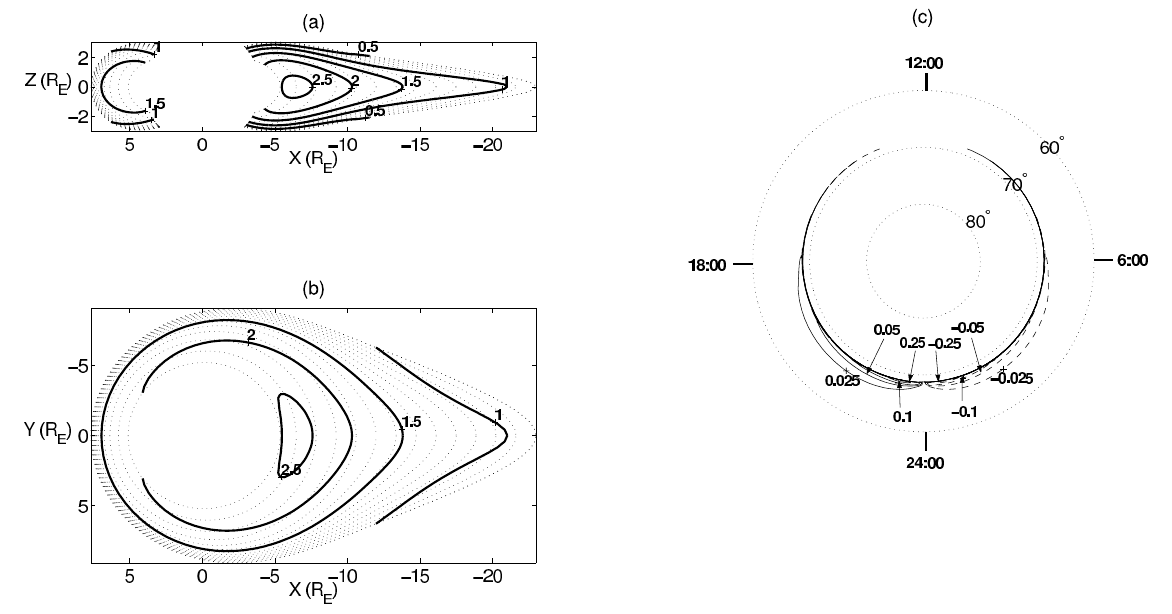
Fig. 4. Contours of constant azimuthal current density J φ in the (a) noon-midnight and (b) equatorial planes for the quiet-time 3-D equilib- rium with Spence-Kivelson pressure; the dotted lines represent constant ψ contours; (c) Contours of field-aligned current density J k in the ionosphere (at 1 R E , computed by assuming J k /B = const. between 1 and 4 R E ); solid lines show currents into the ionosphere, while dashed lines currents out of the